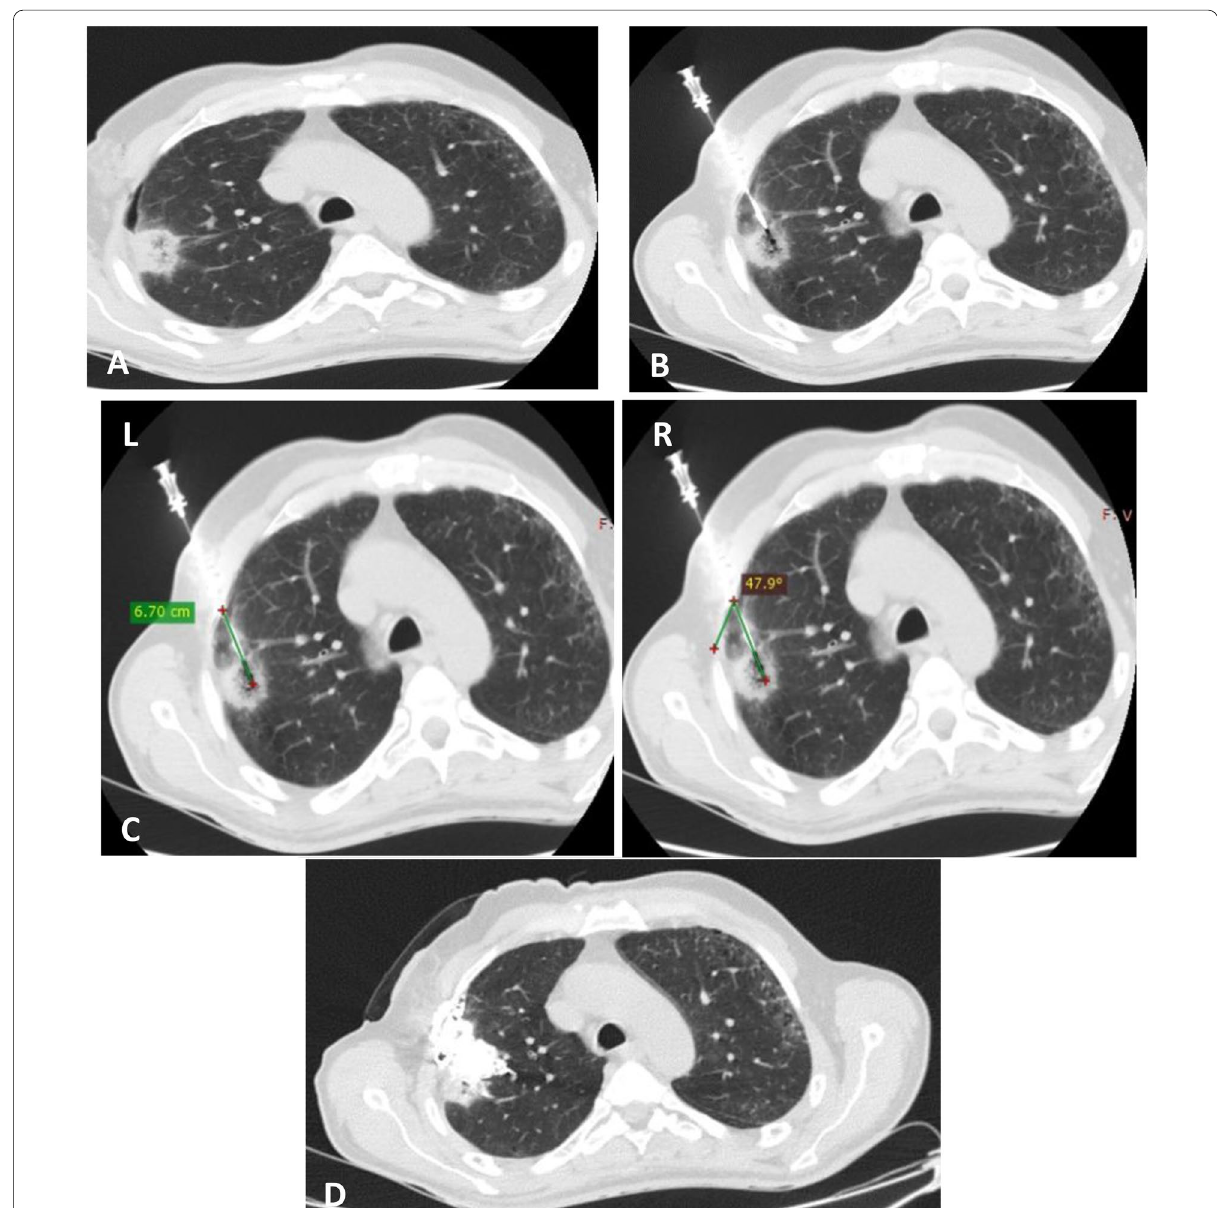
Fig. 1 A Right upper lobe ground glass nodule with pre-procedural rim of pneumothorax prior to intervention, the lesion was invading the adjacent pleural surface. B Single coaxial pleural pass 4.5 cm till the edge of the lesion. C Left: 18-G tru-cut needle was inserted with 2-cm throw. Right: needle pleural angle was 48. D Gelfoam injection sealed the coaxial pathway and the pre-procedural